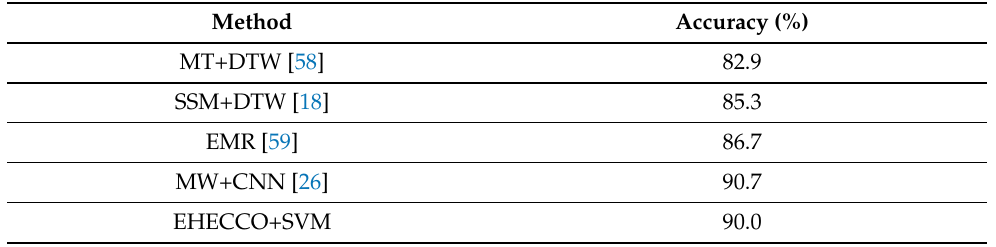
Table 3. Comparing results of Mocap-based action recognition (CMU subset database). The average accuracy is reported concerning the cited works vs. our approach—EHECCO+SVM.